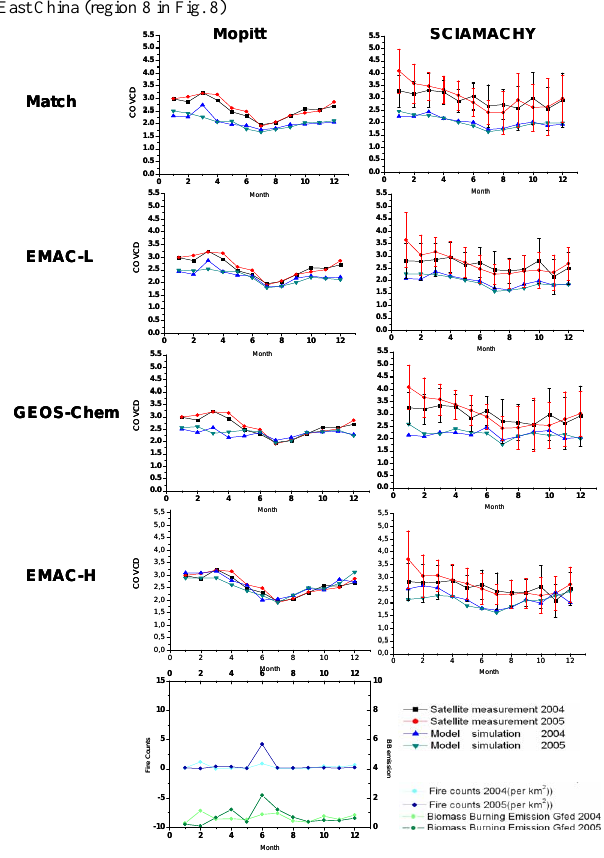
Fig. 13 Comparison of the monthly mean CO VCDs (in units of 10 18 molec/cm 2 ) between the Fig. 13. satellite measurements (left: MOPITT; right: SCIAMACHY) and model simulations for three of the regions indicated in Fig. 8 (similar comparisons for the other regions indicated in Fig. 8 are shown in Fig. A6 in the appendix). All comparisons are done for only collocated measurements/model results; also the specific sensitivities of the satellite instrument have been considered (see text). In the bottom row fire counts from ATSR (in units of 10 -4 per km 2 per month), and GFED emissions used in the models (in units of 10 13 molecules/cm 2 /s) are shown. The error bar of SCIAMACHY refers to the unbiased estimator of a weighted population variance. EMAC-L refers to low (T42) and EMAC-H to high (T106) spatial resolution. 46